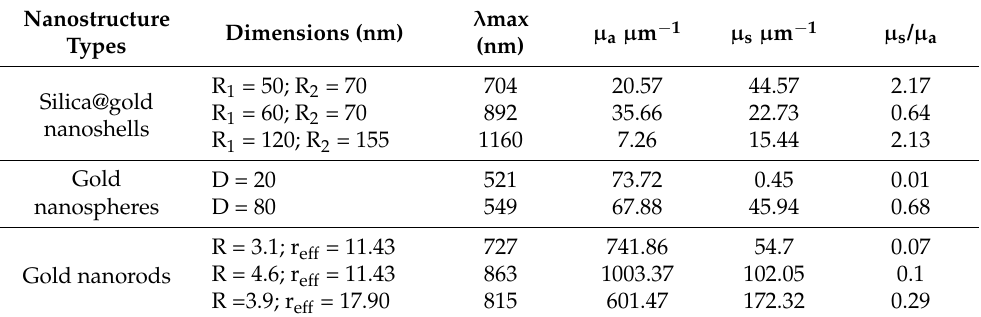
Table 2. Determined maximum wavelength ( λ max) and the ratio of scattering efficiency ( µ s ) to absorption efficiency ( µ a ) for GNPs with various shapes and sizes